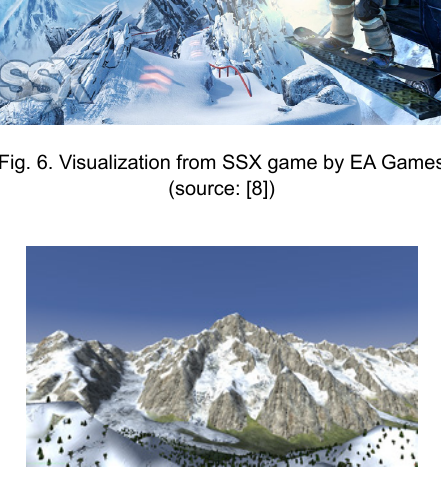
Fig. 7. Visualization of Mont Blanc in the Flight